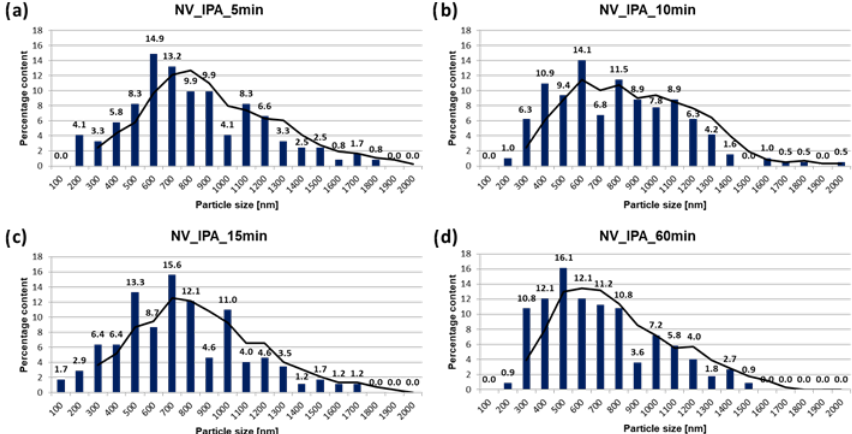
Figure 4. NV-rich nanodiamond particle size distributions in NV_IPA_5 min ( a ), NV_IPA_10 min ( b ), NV_IPA_15 min ( c ), NV_IPA_60 min ( d ).